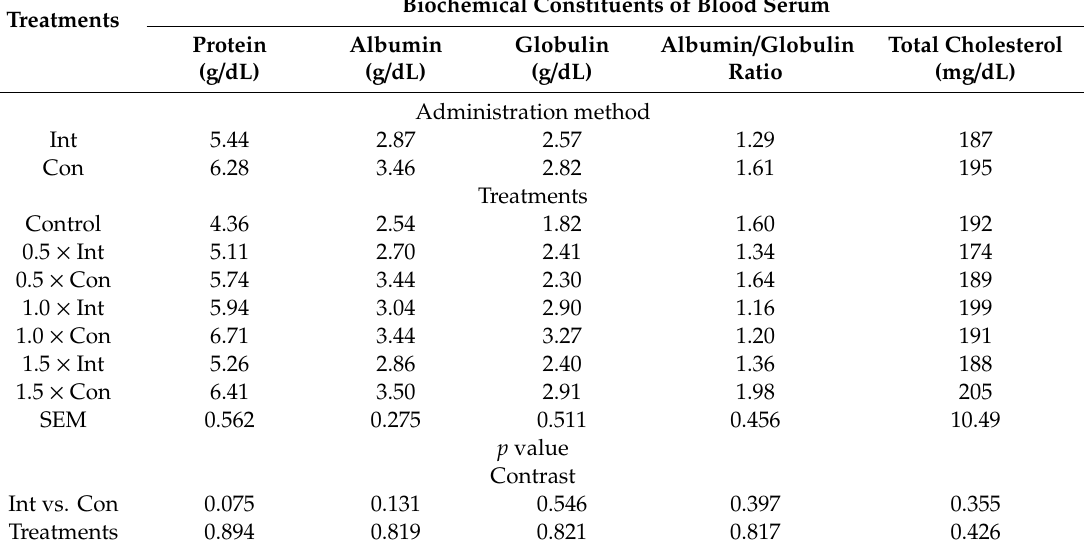
Table 7. E ff ects of multienzymes supplemented continuously or intermittently on biochemical constituents of blood serum of Arbor Acres broiler chicks during 1–35 days of